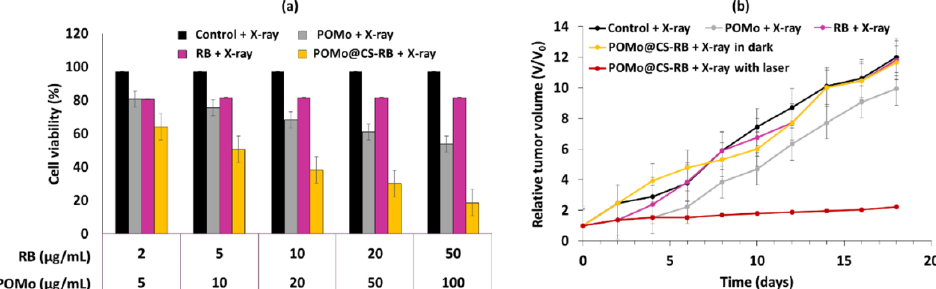
Figure 42. ( a ) In vitro cell viability of 4T1 cells incubated for 24 h with various concentrations of RB, POMo and POMo@CS-RB under X-ray irradiation (2 Gy). ( b ) Relative tumor volume under different treatment conditions (X-ray irradiation (2 Gy), 25 mg/Kg). Adapted from Maiti et al. [109]. Sun et al. [110] explored the combination of PDT and radiation therapy using hydrodynamic diameter of GRDs was 7.7 ± 1.4 nm. RB and GRDs were excited at 525 nm